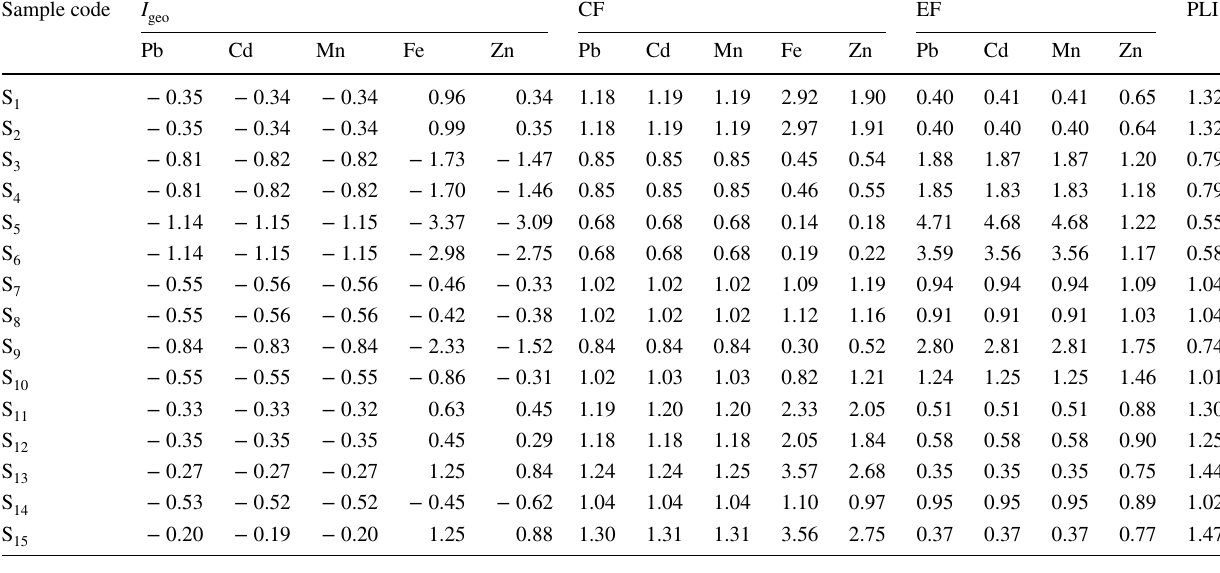
Table 10 Geoaccumulation index, contamination factor, enrichment factor, and pollution load index of heavy metals in groundwater samples of Ibadan metropolis Sample